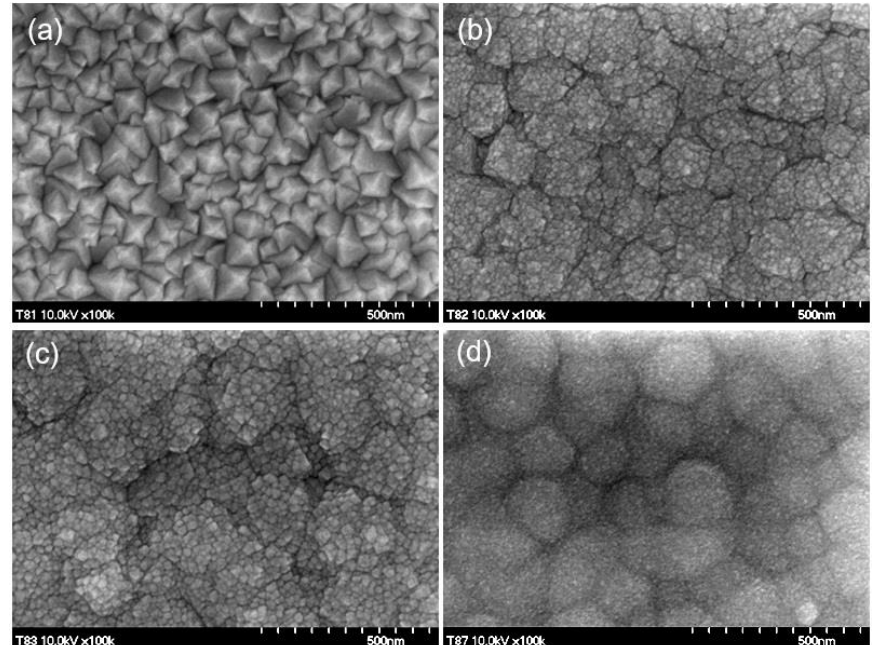
Figure 1. ( a – d ). SEM images of ITO:Ga films with 0, 5, 10 and 15 at.% Ga.